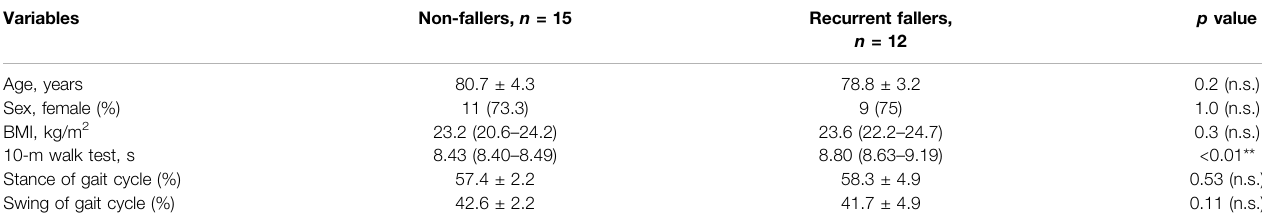
TABLE 1 | Basic characteristics of the old non-fallers and recurrent